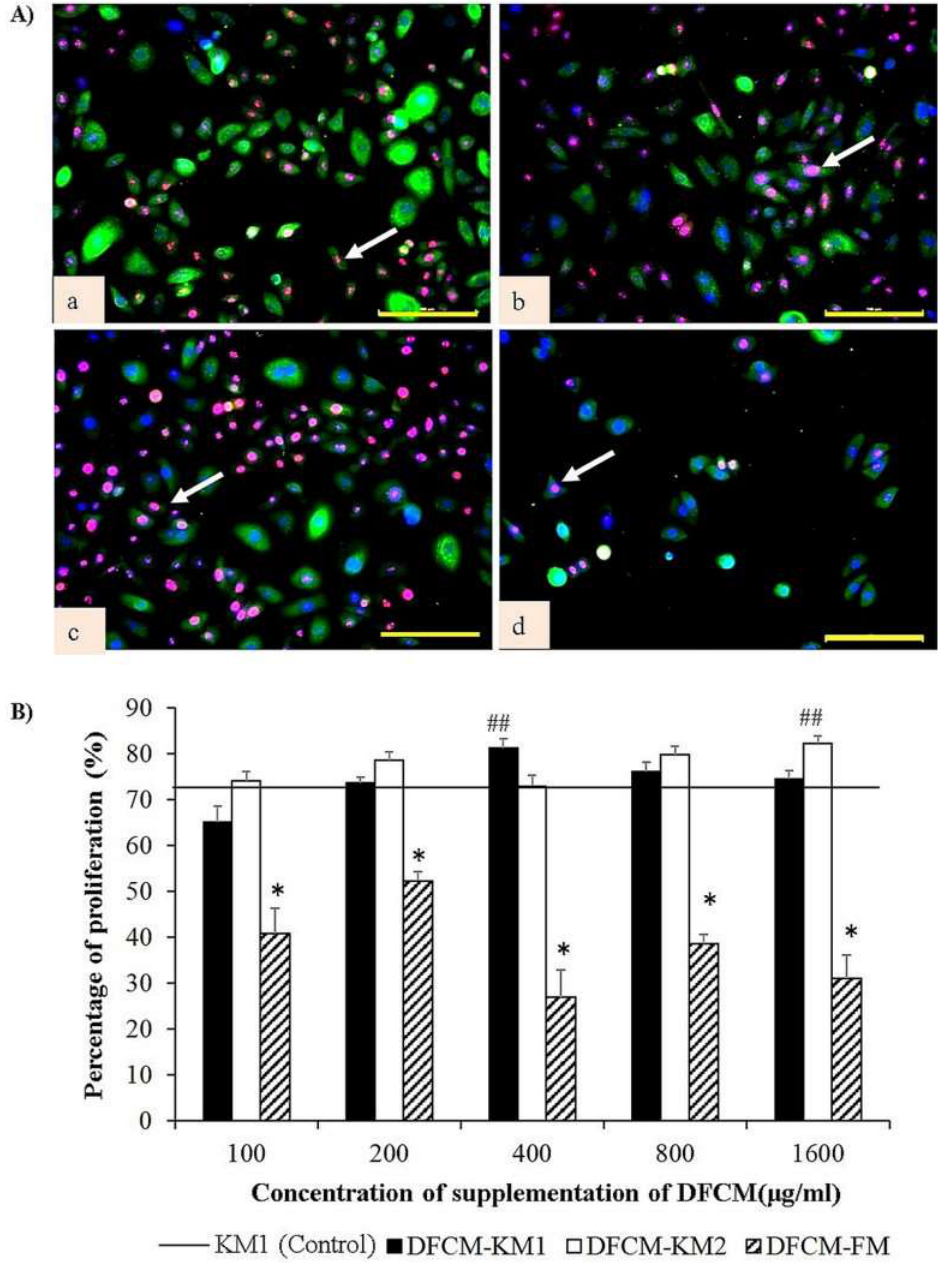
The e ff ect of DFCM on keratinocyte proliferation. ( A ) Representative images of Figure 2. The effect of DFCM on keratinocyte proliferation. ( A ) Representative images of immunocytochemistry staining of keratinocytes supplemented with DFCM (100 µ g / mL), with immunocytochemistry staining of keratinocytes supplemented with DFCM (100 µg/mL), with anti– anti–cytokeratin14(green),anti-Ki67(red)andnuclearstaining(blue);( a )KM1control,( b )KBM + DFCM-KM1, cytokeratin 14 (green), anti-Ki67 (red) and nuclear staining (blue); (a) KM1 control, (b) KBM+DFCM- ( c ) KBM + DFCM-KM2, and ( d ) KBM + DFCM-FM. Arrow indicates positive expression of proliferative cell KM1, (c) KBM+DFCM-KM2, and (d) KBM+DFCM-FM. Arrow indicates positive expression of with anti-Ki67. Scale bar is 100 µ m. ( B ) Quantitative evaluation (in percentage) of proliferative cells. Arrow proliferative cell with anti-Ki67. Scale bar is 100 µm. ( B ) Quantitative evaluation (in percentage) of shows representative cell with positive anti-Ki67 expression. ## represents significantly more proliferative proliferative cells. Arrow shows representative cell with positive anti-Ki67 expression. ## represents cells in the DFCM group than in the control; * represents significantly fewer proliferative cells than in the significantly more proliferative cells in the DFCM group than in the control; * represents significantly other groups ( p < 0.05) ( n = 3). Scale bar = 100 µ fewer proliferative cells than in the other groups ( p < 0.05) ( n = 3). Scale bar= 100  m.